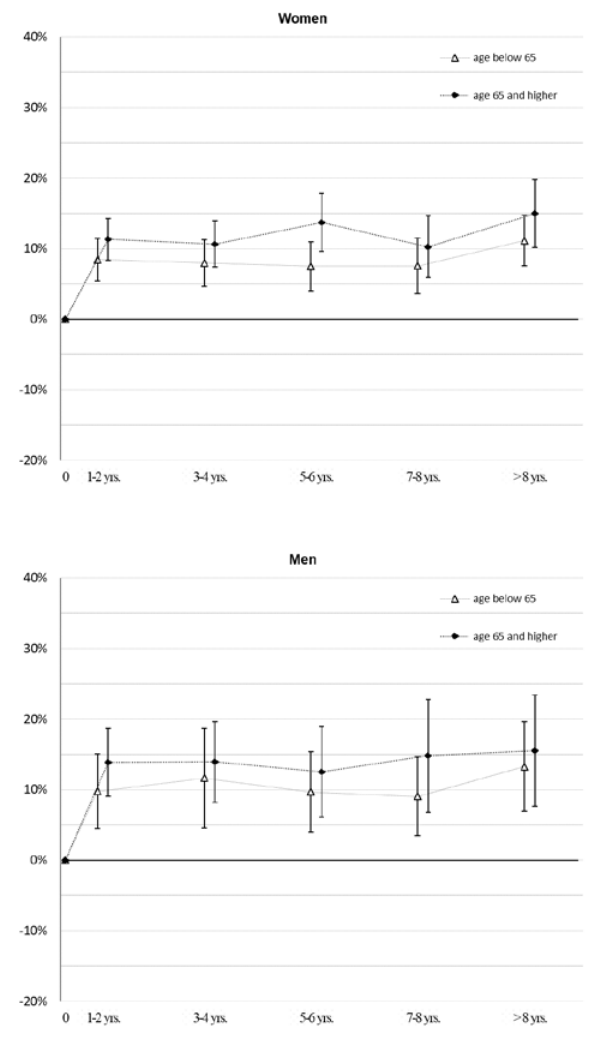
Figure 4 : Age-differences in time-effects of relationship endings on social isolation (concurrent isolation from all social spheres; linear-probability models with fixed effects, percentage points and 95%-confidence limits) (continued) C) Partner loss by